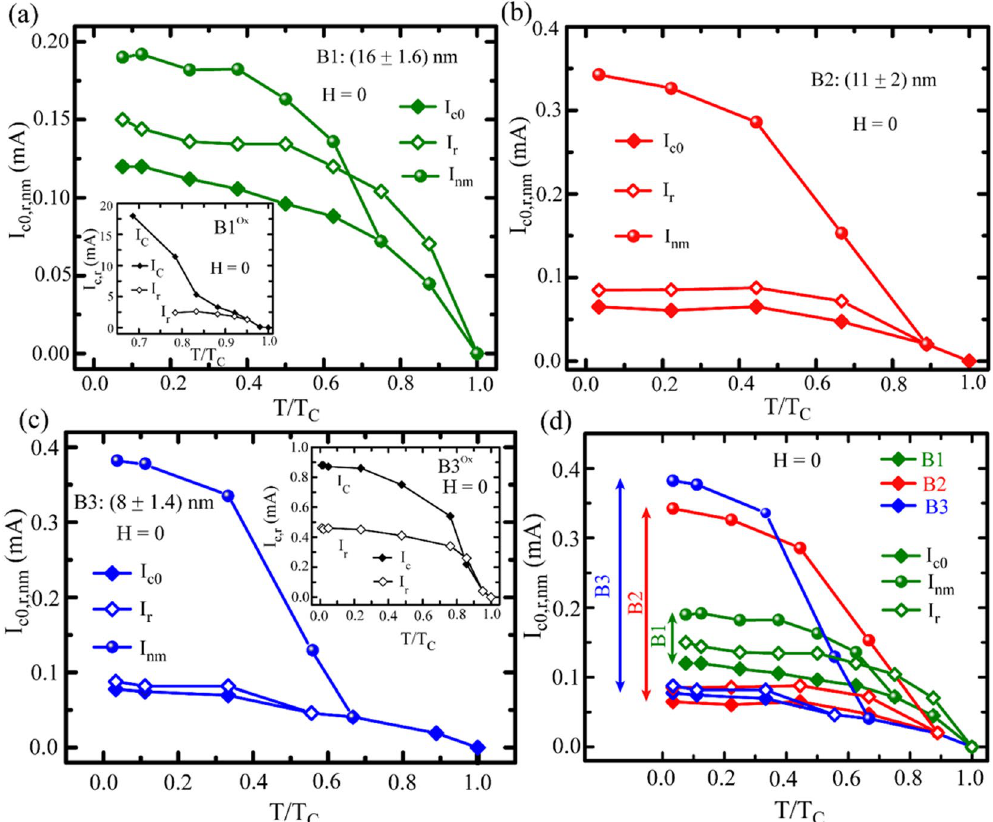
Figure 5. Temperature dependence of the characteristic currents for samples B1 ( a ), B2 ( b ) and B3( c ). The temperature dependent critical currents and retrapping currents for the control samples on oxide substrates B1 ox and B3 ox are presented in the insets of ( a ) and ( c ), respectively. ( d ) Comparison of the critical currents between all the three nitride samples. Here, the critical temperature T C is defined as the temperature at which IVC becomes